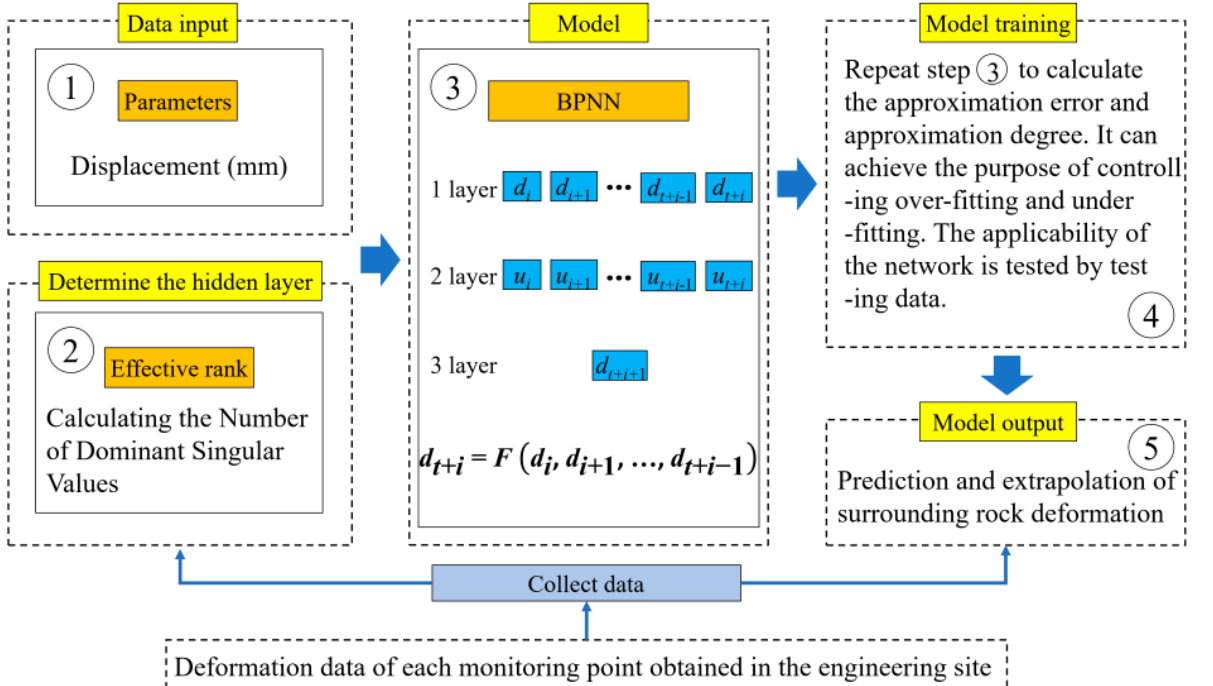
Figure 2. Principle of intelligent analysis of tunnel surrounding rock deformation based on BPNN. (adapted from [36], with permission from MDPI, 2022).